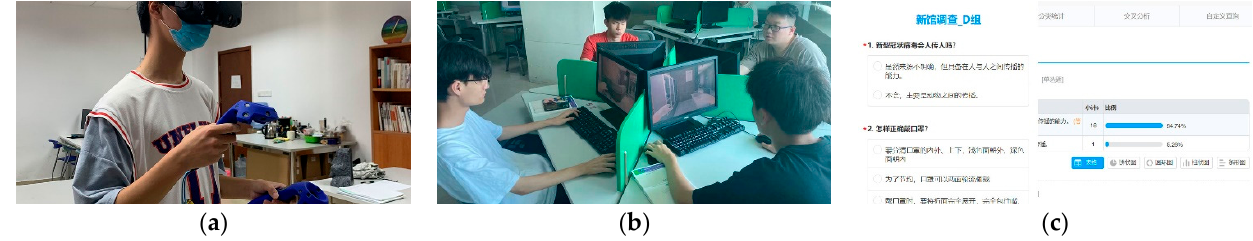
Figure 14. User Experiment: ( a ) Group A User Test; ( b ) Group B User Test; ( c ) Online Questionaries (WJX.cn Platform, accessed on 22 September 2021).